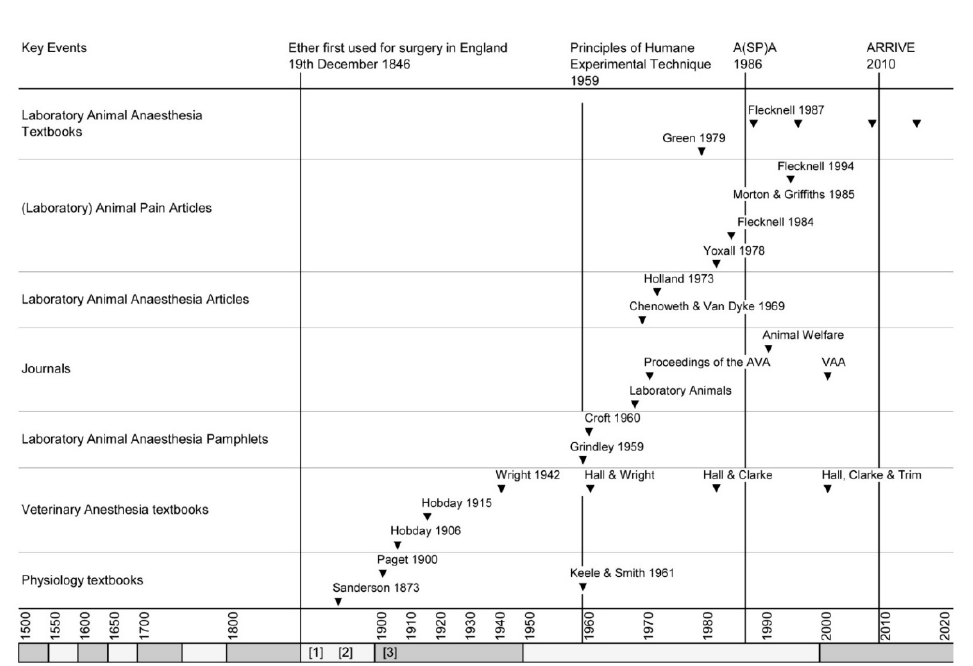
Figure 3. Dates of the publication of material contributing to promotion of anaesthetics and analgesics in animal experiments. Alternatively shaded x axis blocks each represent a 50 year epoc. A(SP)A 1986: